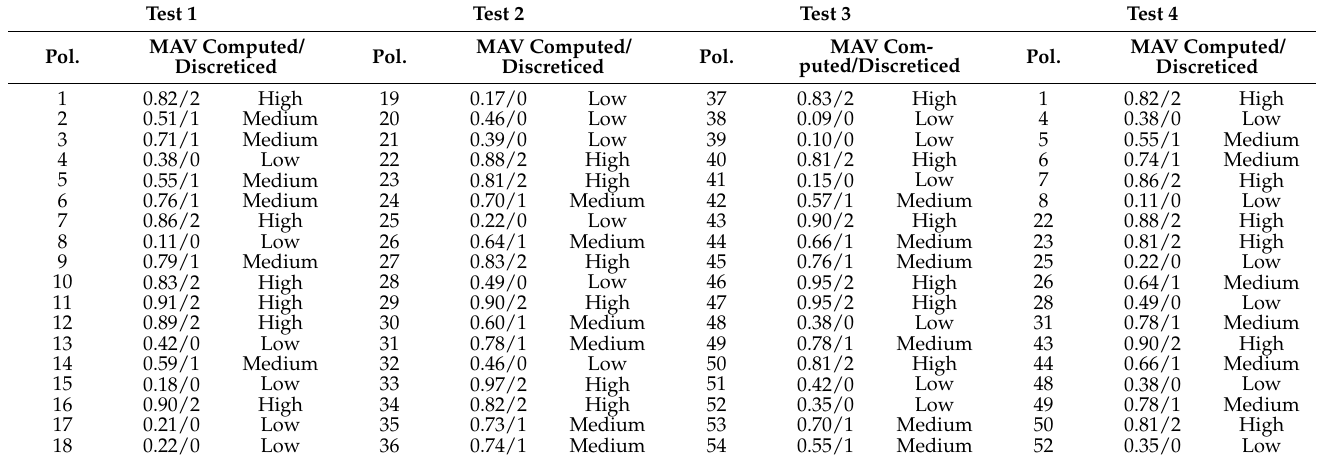
Table A1. Results provided by the GA. MAV Experiment.